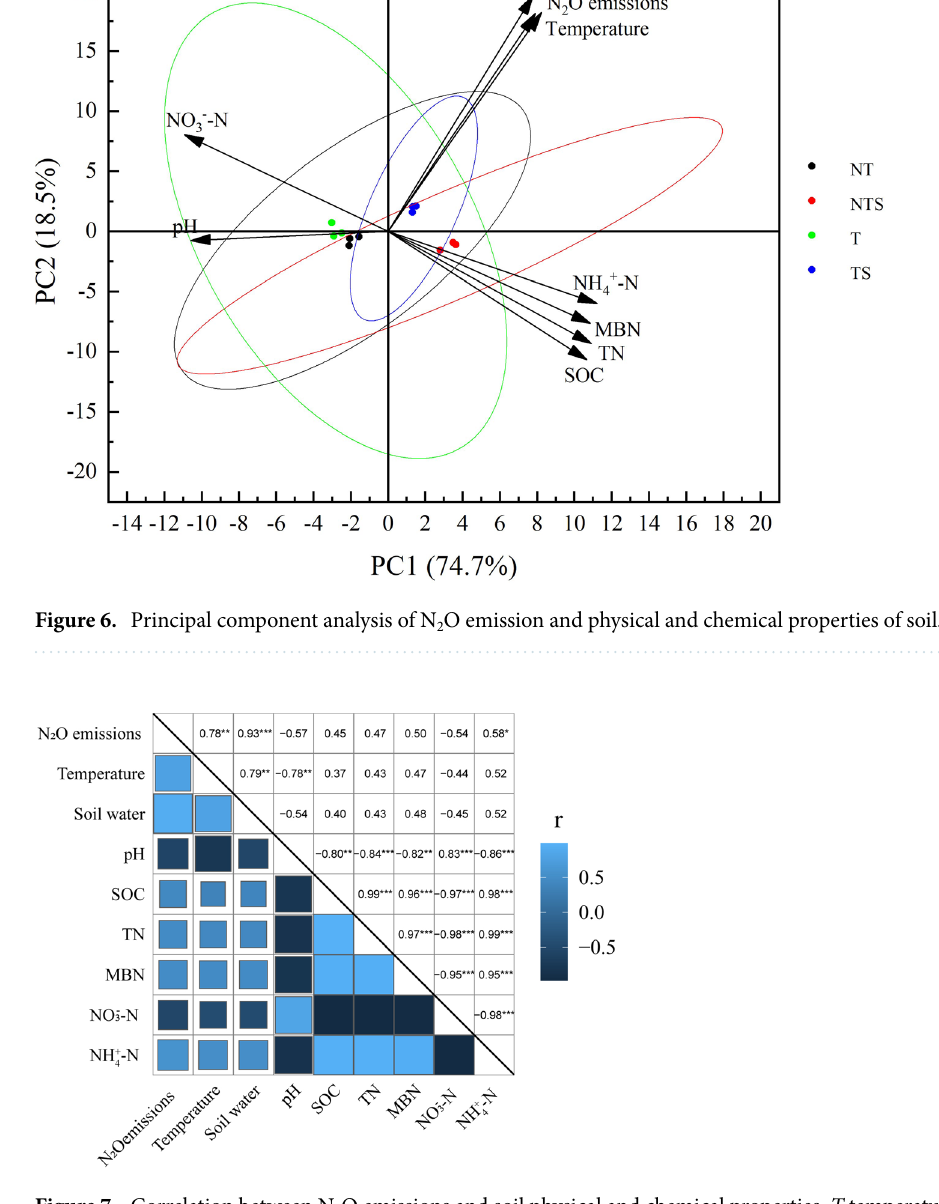
Figure 7. Correlation between N 2 O emissions and soil physical and chemical properties. T temperature. *Indicates significant at 0.05 level, **indicates significant at 0.01 level, ***indicates significant at 0.001